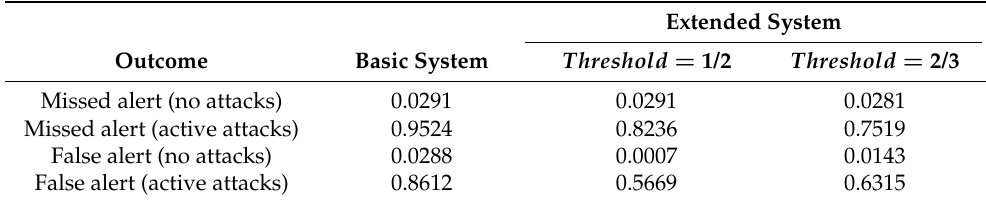
Table 7. Resulting risk-exposure scores for the system under normal operation and under active